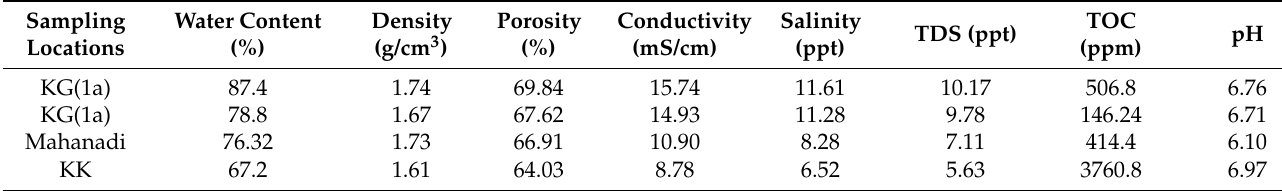
Table 2. Physical properties of sediment samples.